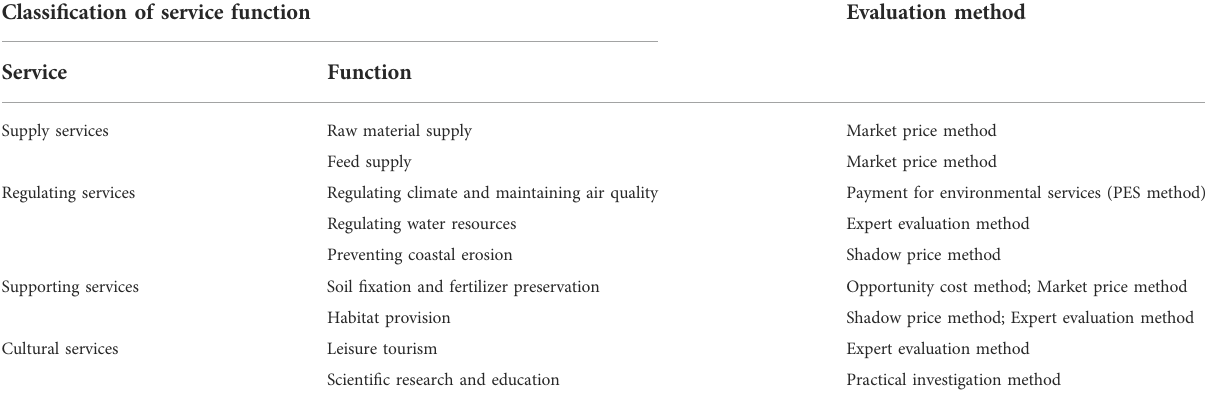
TABLE 1 Monetary value evaluation methods of China ’ s mangrove ecosystem services.